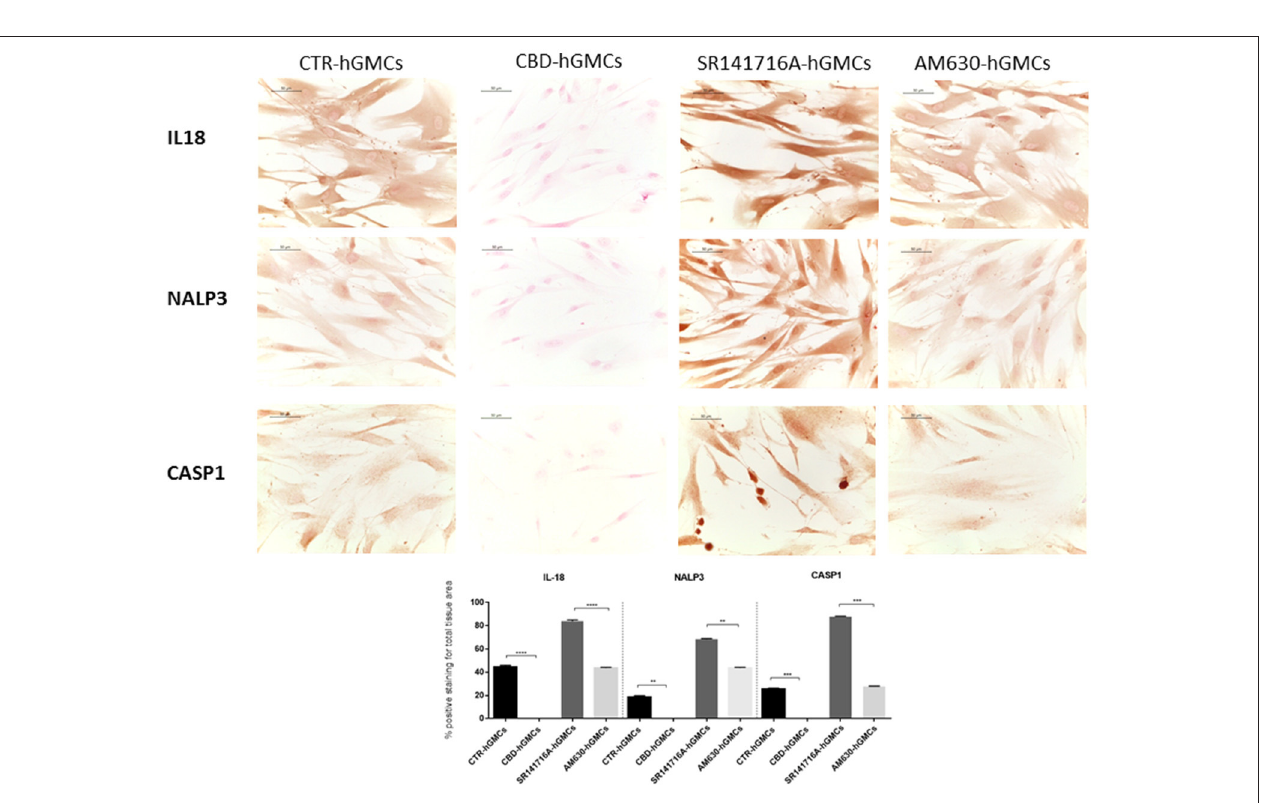
FIGURE 2 | Immunocytochemical staining for IL18, NALP3 and CASP1. CBD-hGMSCs showed a negative staining for IL-18, NALP3, and CASP1 compared to CTR-hGMSCs. Instead, hGMSCs-SR141716A and hGMSCs-AM630 showed a significant positive staining for IL-18, NALP3, and CASP1 compared to CBD-hGMSCs. The graph represented the densytometric quantitative analysis. For IL-18 CTR-hGMSCs vs. CBD-hGMSCs *** p < 0.001; SR141716A-hGMSCs vs. AM630-hGMSCs **** p < 0.0001. For NALP3 CTR-hGMSCs vs. CBD-hGMSCs ** p < 0.01; SR141716A-hGMSCs vs. AM630-hGMSCs ** p < 0.01. For CASP-1 CTR-hGMSCs vs. CBD-hGMSCs *** p < 0.001; SR141716A-hGMSCs vs. AM630-hGMSCs *** p <